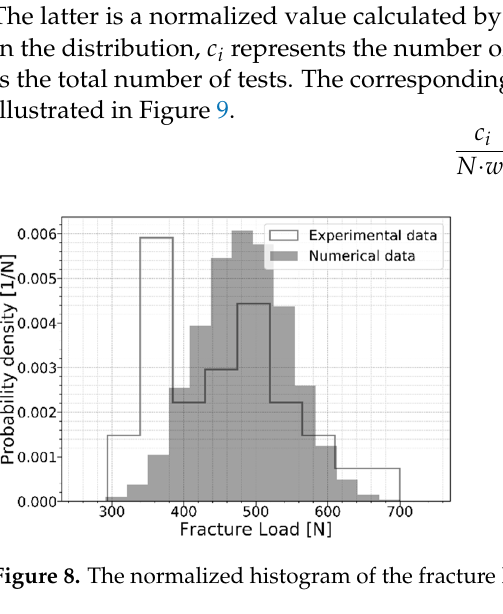
Figure 7. Fracture location (yellow) for bottom surface (axis dimension in mm).